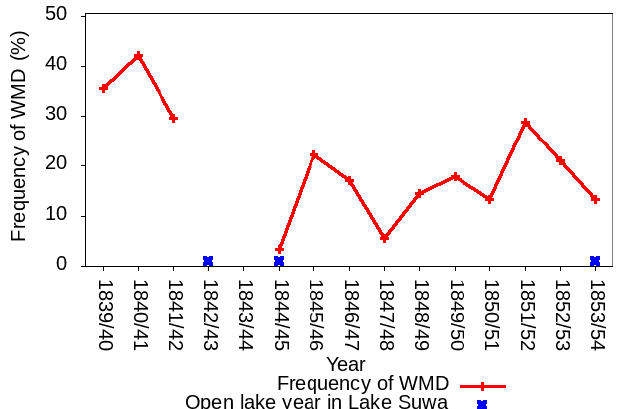
Figure 11. Interannual variations in the frequency of winter mon- soon outbreak days (WMDs) for the years 1839/40–1853/54. The red solid line indicates the frequency of WMDs, and the blue dots indicate Lake Suwa’s open-lake years.